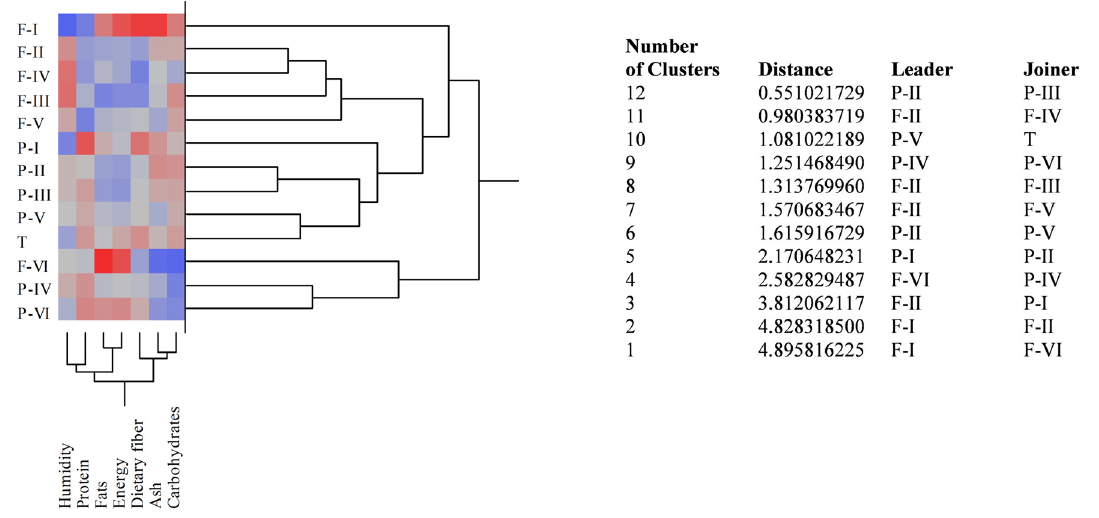
Figure 1. Agglomerative two-way hierarchical clustering analyses of the nutritional profiles of blanched skin (BS) samples belonging to the different producers of Fascionello (F), Pizzuta (P), and Tuono (T) cultivars.